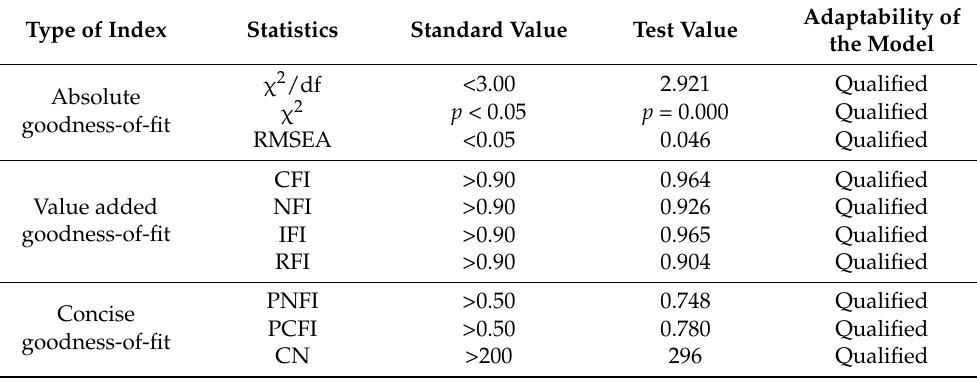
Table 3. Results of model fitting test.